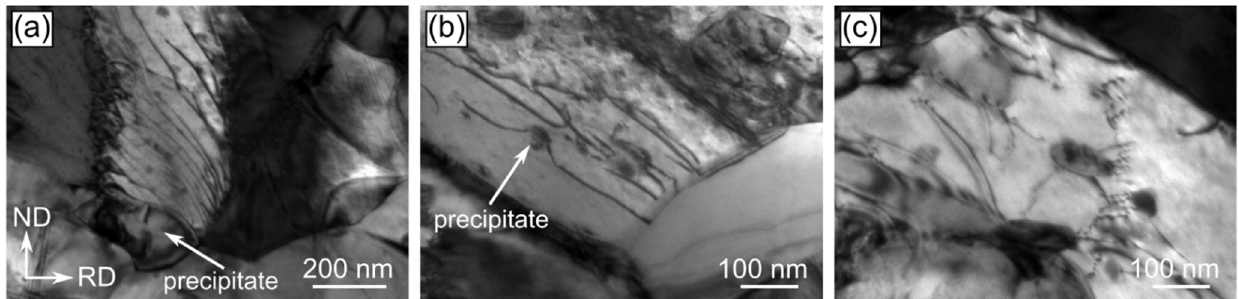
Figure 13. TEM/BF microstructure of the cold-rolled Zn-1Cu alloy with 90% of reduction after uniaxial tensile test: pile-up of dislocations around the CuZn 4 precipitate ( a ), bowing of dislocation around the CuZn 4 ( b ) and dislocations annihilation into sub-grain around the CuZn 4 ( c ).